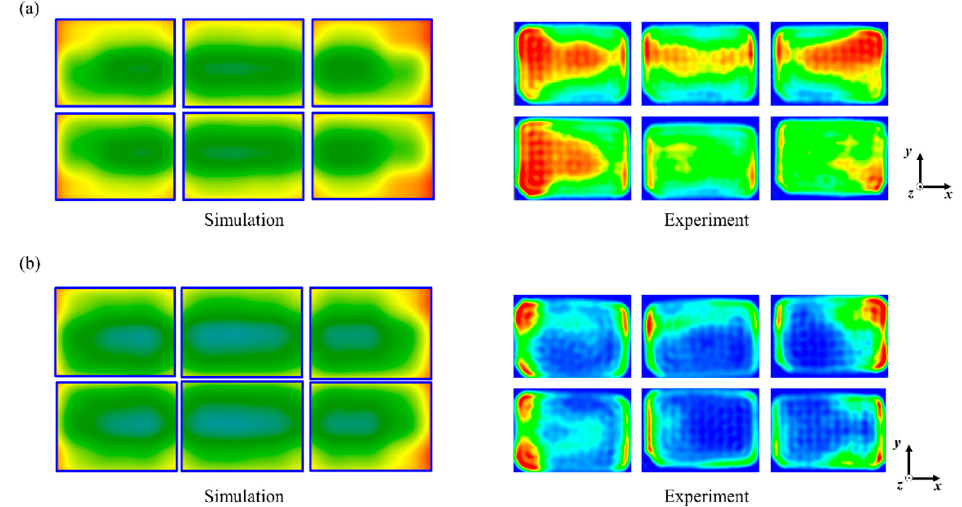
Figure 6. Comparisons of heating patterns on the middle layer of model foods: ( a ) 0.0%-added-salt and ( b ) 0.7%-added-salt model foods.